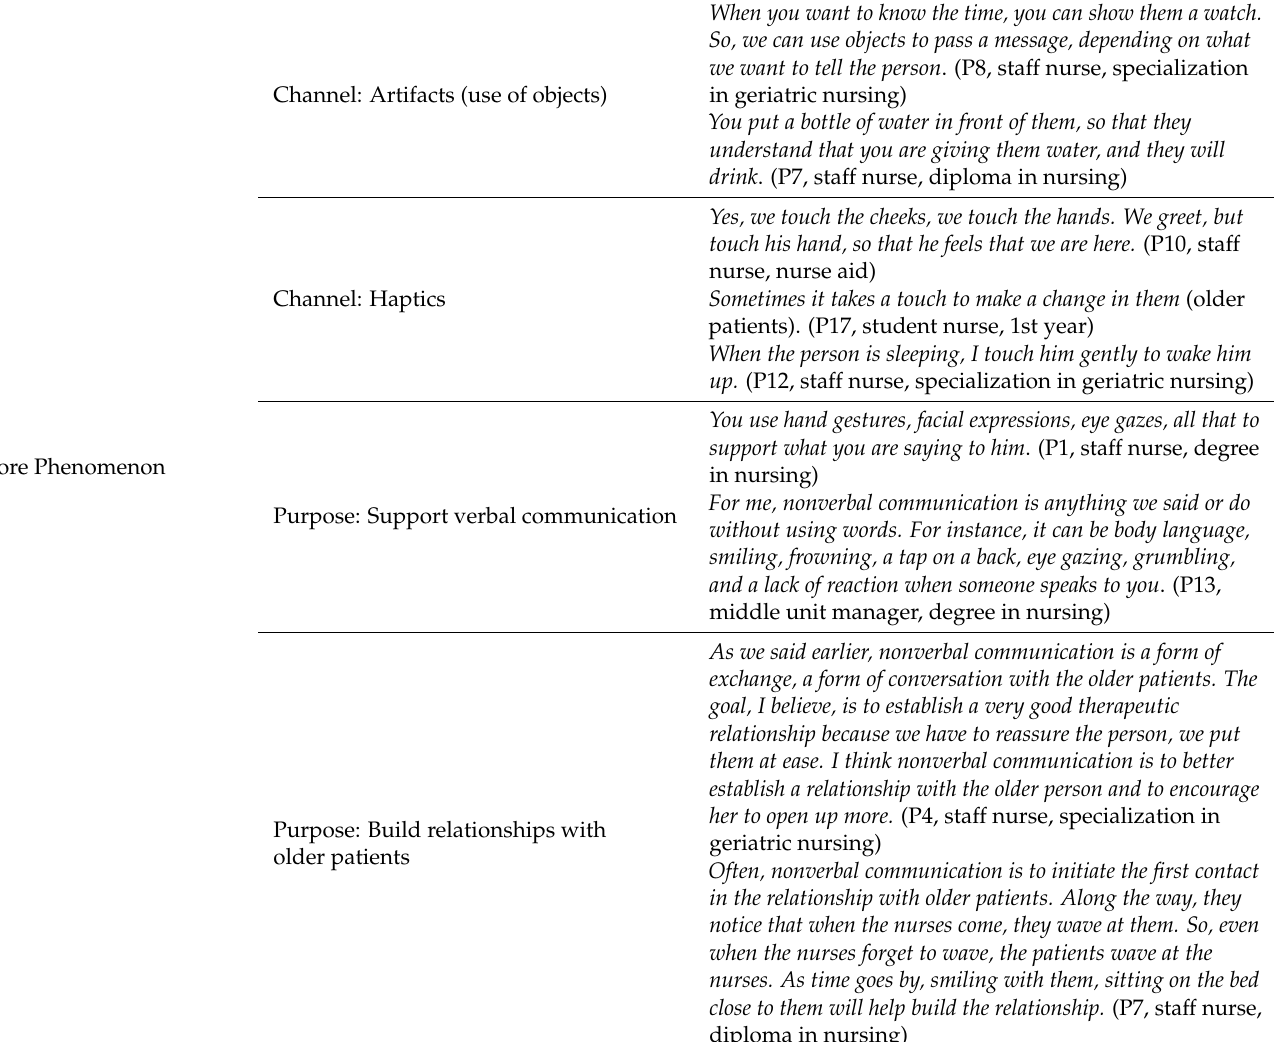
Table 3. Extracts of the core phenomenon forming the basis for developing the model.